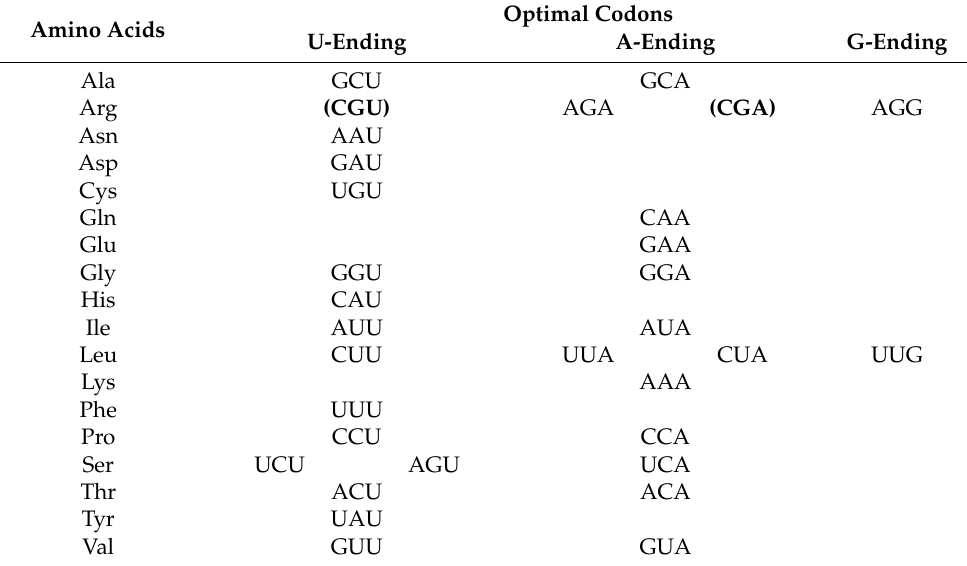
Table 3. Optimal codons identified in ten species of Cucurbitaceae. Amino Acids